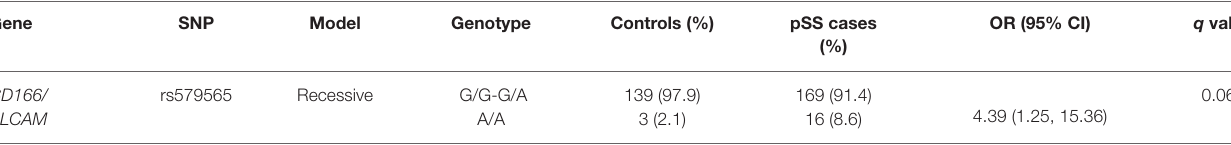
TABLE 2 | Logistic regression analyses of CD166/ALCAM SNP association with pSS susceptibility.